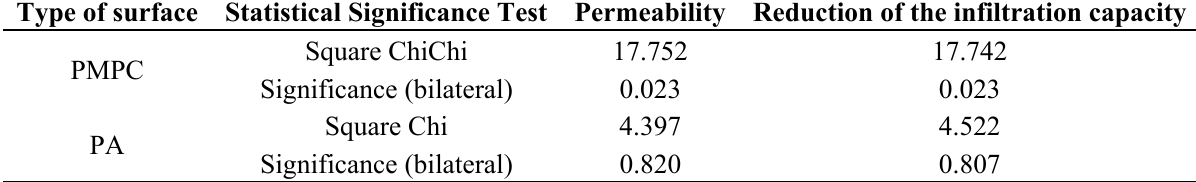
Table 5. Significance analyses for k-independent samples (measurement zones) by using Kruskal Wallis